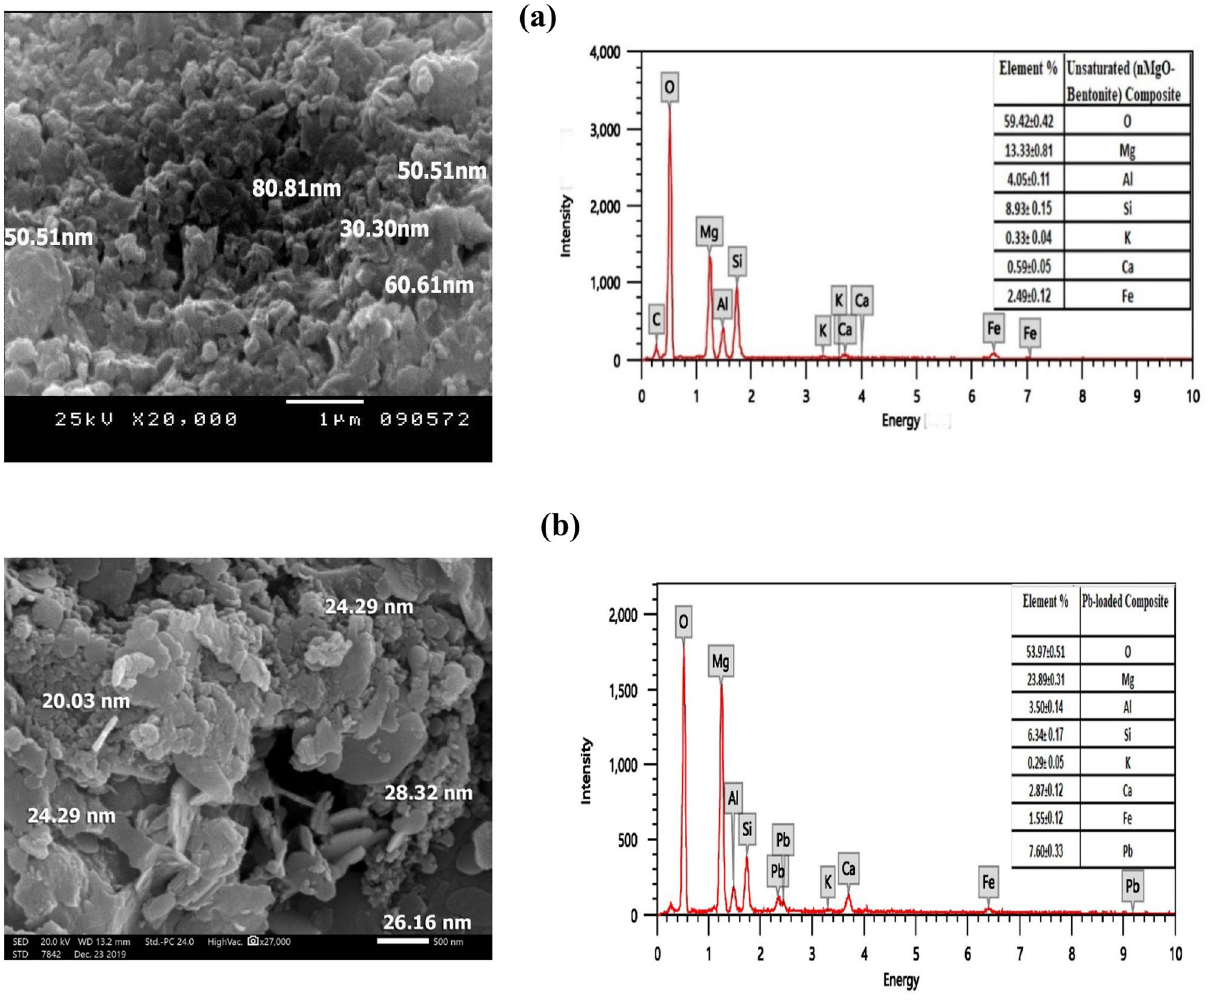
Figure 2. Scanning electron microscopy (SEM) image and energy-dispersive X-ray (EDX) spectrum of ( a ) nanocomposite and ( b ) Pb-saturated stretching vibrations OH groups coordinated to two Al atoms, a band at1639 cm −1 correspond to C=C stretching of alkene. The two bands at 1484 and 1034 cm −1 assigned to the Si–O vibration mode whereas the band observed at 538 cm −1 corresponds to the deformation mode of Al–O–Si group. Retention of Pb(II) on the surface of the nanocomposite (nMgO and Bentonite) leads to some spectral changes. The bands at 1639 cm −1 and 1034 cm −1 increased in intensity and shifted to 1633 and 1033 cm −1 , respectively whereas bands at1484, and 538 cm −1 increased in intensity. Such changes indicate the active rules of Al–O–Si, Al–OH–Al, Si–O stretching groups in Pb(II) removal by nanocomposite (nMgO-bentonite) 31 . Adsorption kinetics and modeling. Adsorption kinetics were carried out to identify the exposure time needed to reach the Pb(II) adsorption equilibrium onto bentonite, and nanocomposite (Fig. 4a). Such informa- tion is crucial since time of equilibrium is the guiding principle for low-cost wastewater treatment application 32 . The adsorption kinetics of Pb(II) by the two studied adsorbents exhibited a biphasic adsorption reaction, a rapid adsorption in the initial 5 min. followed by a slow adsorption afterwards. The percentage of Pb(II) adsorbed by nanocomposite (nMgO-bentonite) at 298 K reached ~ 94% in the first five min. and followed by slow adsorption (Fig. 4a). Kinetics adsorption data were expressed using four mathematical models for further description of Pb(II) adsorption mechanisms 33 . First-order 34 , Elovich 35 , intraparticle diffusion 36 , and modified Fruendlich 37 kinetic models were employed. The compliance of the experimental data and the predicted model values is based on the determination coefficient (R 2 ) and the standard error of estimate (SE) values. A high R 2 and low SE values are indicators for the successful description of the model to Pb(II) adsorption kinetics. The Kinetics model constants, R 2 and SE values for Pb(II) adsorption by Bentonite and nanocomposite (nMgO-bentonite) are given in Table 1. The R 2 values obtained for power function model (Table 1) were higher and SE values were lower than R 2 and SE of the other kinetic models studied.This confirmed that the adsorption process of Pb(II) by the